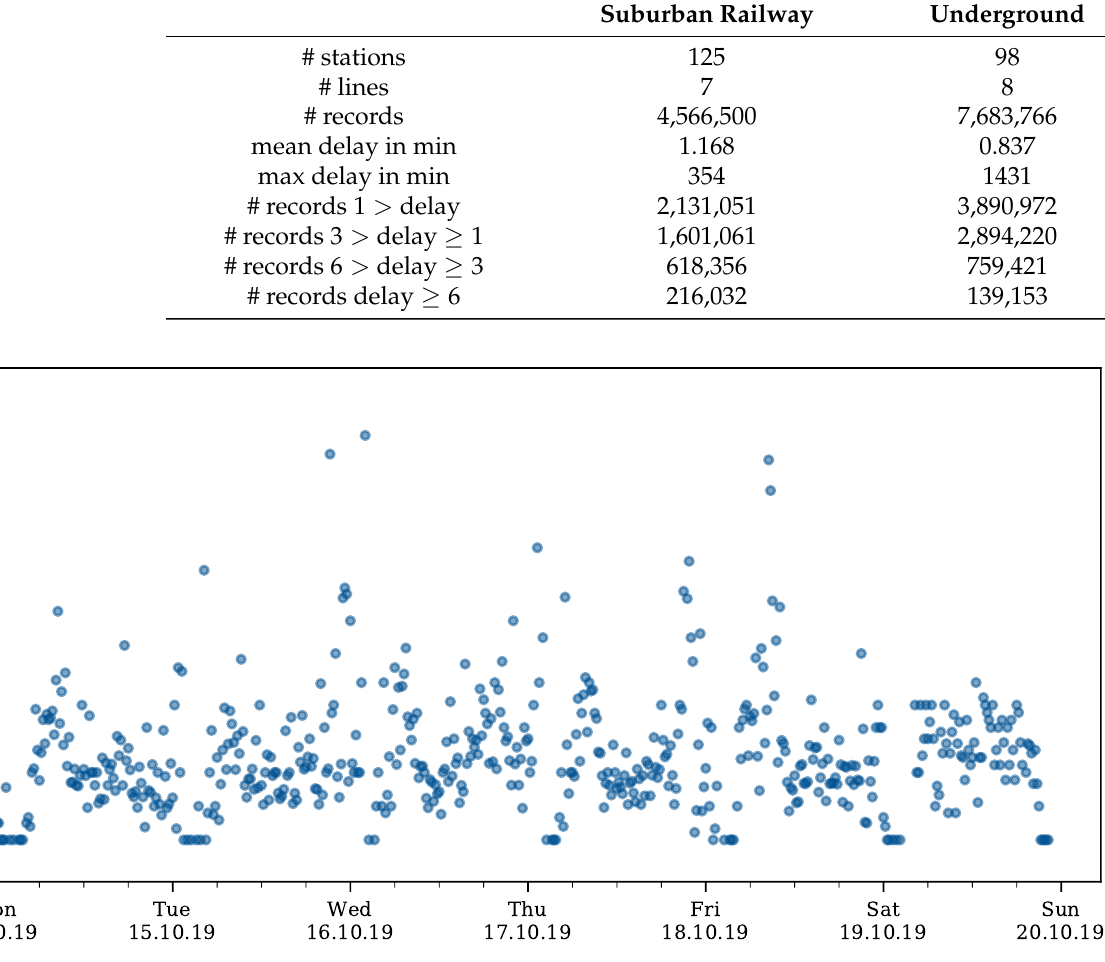
Table 1. Data Description Public Transit.